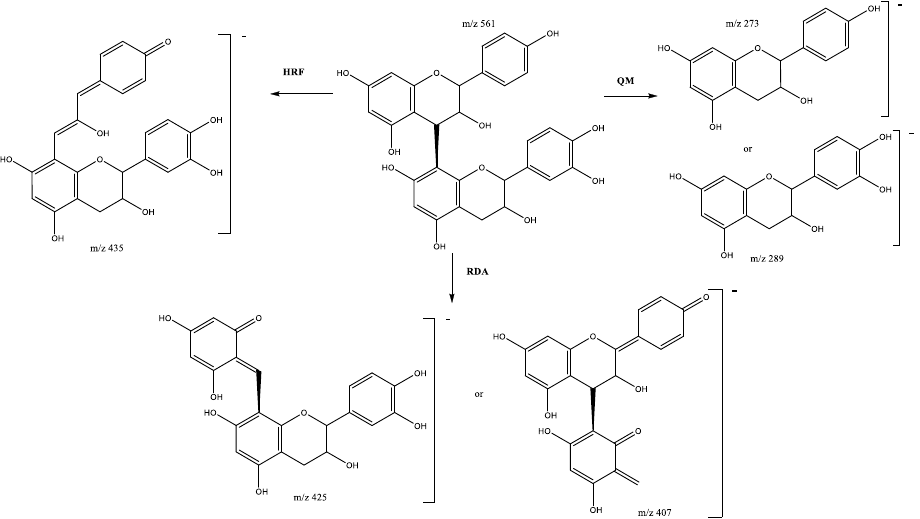
Figure 5. Propelargonidin (epi)afzelechin-(epi)catechin B-dimer fragmentation pathway. Four types of B-type trimers were found in U. tomentosa leaves proanthocyanidin- enriched extract, whose chromatograms are summarized in Figure 6.